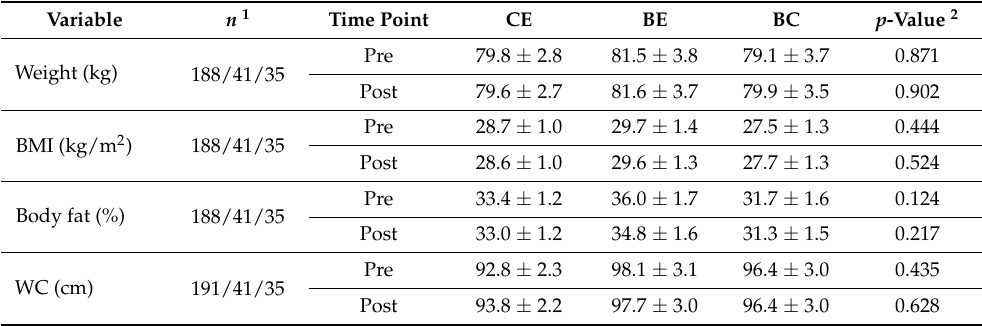
Table 5. Body composition variables compared among groups over time. Data expressed as least squares mean ±